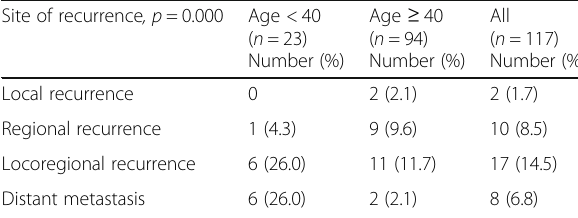
Table 2 Recurrence patterns in young and older patients Site of recurrence , p = 0.000 Age < 40 ( n = 23)